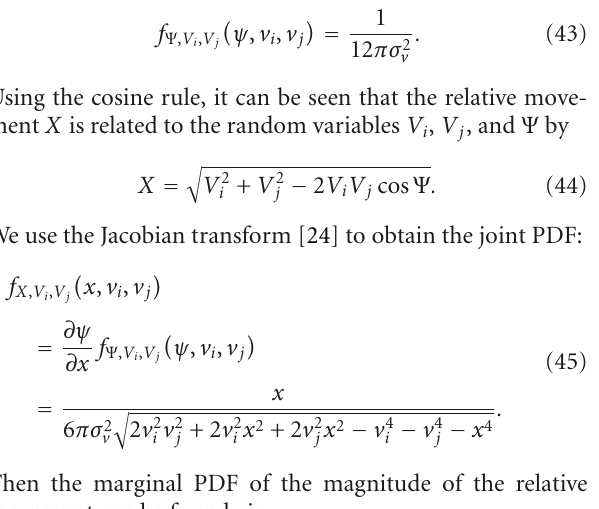
Figure 5: Relationship between the node movement vectors (cid:2) V i and j , respectively, relative movement vector, (cid:2) X , sepa- j of nodes (cid:2) L ration vector at epoch m , m , and separation vector after one epoch, (cid:2) L m +1 . Solid lines indicate actual vector positions and dashed lines indicate vectors shifted for illustration purposes. The dotted circles indicate the loci of possible positions for nodes i and j at epoch m +